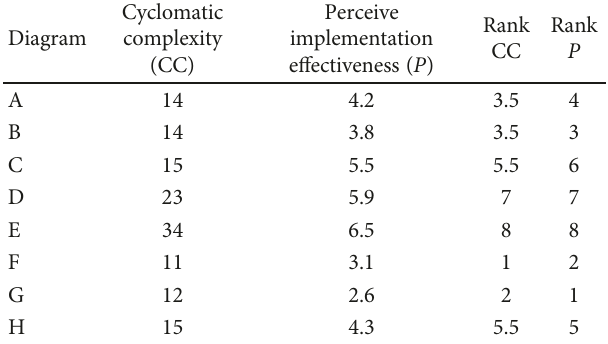
Table 5: Data for Spearman correlation coe ffi cient calculation. Topological Diagram complexity ( C ) 3